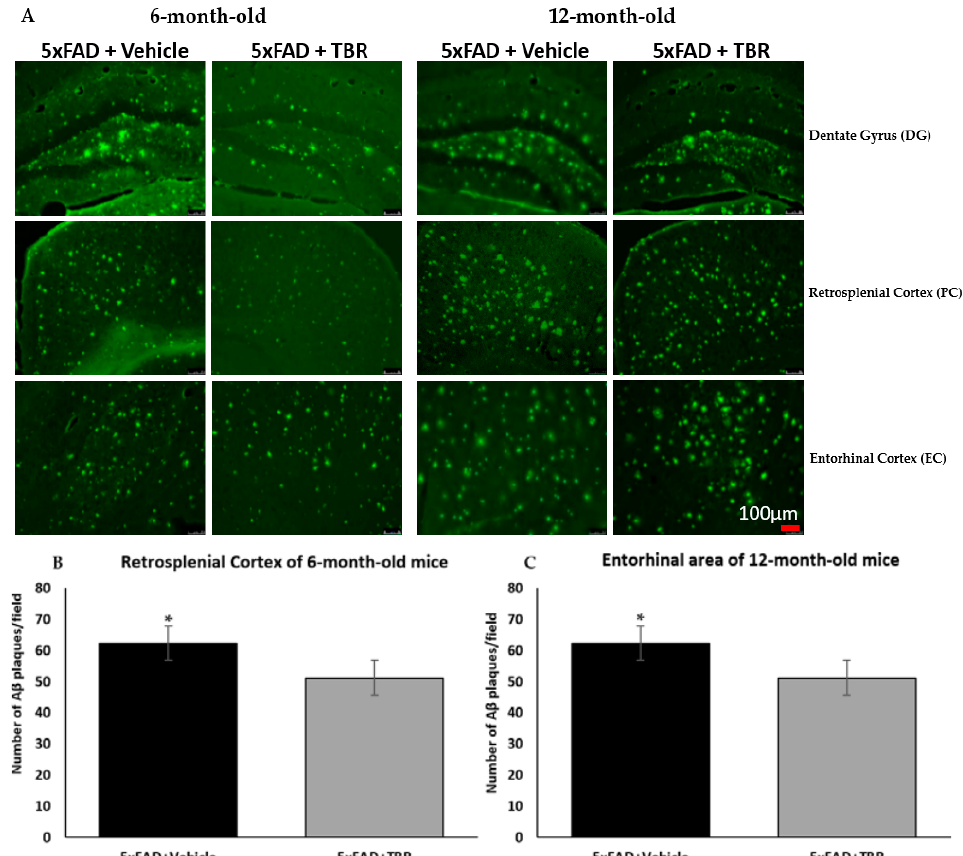
Figure 10. ( A – C ). Effect of TBR on Aβ plaque deposits in 5xFAD mice. ( A ) Representative image from three locations: the dentate gyrus (DG), retrosplenial cortex (RSC), and the entorhinal cortex (EC) for 6- and 12-month-old animals. ( B ) Using a two-tailed t -test, there was a significant difference in total amyloid β deposits in the retrosplenial cortex between 5xFAD 6-month-old mice treated with TBR and 5xFAD mice treated with vehicle. ( C ) Using a one-tailed t -test, there was a significant difference in total amyloid β deposits between 5xFAD 12-month-old mice treated with TBR and 5xFAD mice treated with vehicle. * p < 0.05.